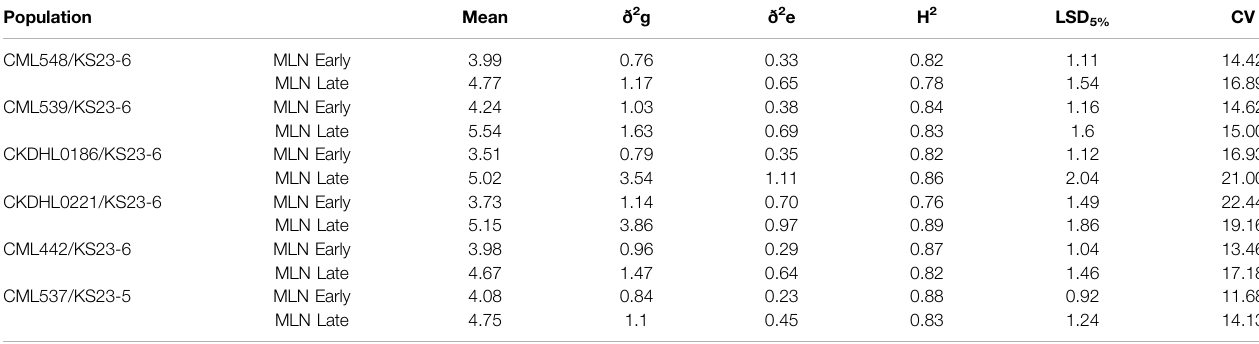
TABLE 5 | Estimates of means, genetic variance, heritability, LSD and coef fi cient of variation in different populations. Population